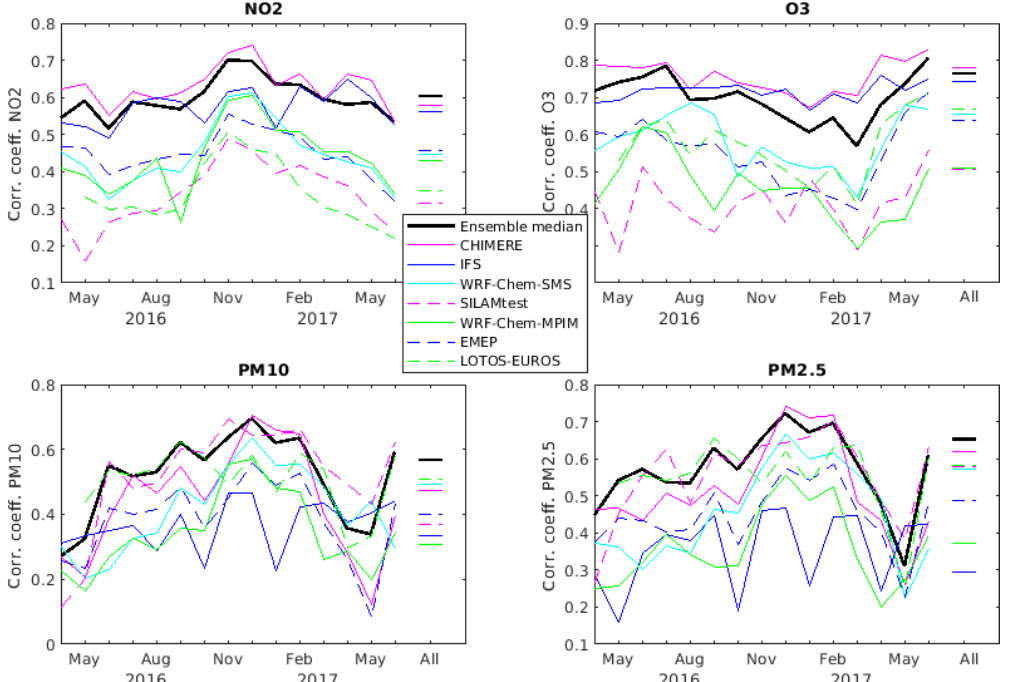
Figure 4. Correlation coefficients based on hourly concentrations of NO 2 , O 3 , PM 10 , and PM 2 . 5 for each month between April 2016 and June 2017 (and for the entire time period, lines on the right side of each